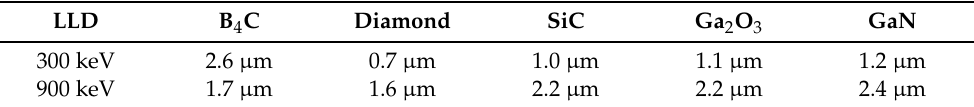
Table 4. Optimal semiconductor thickness with optimal B 4 C converter layer thickness for diamond, SiC, Ga 2 O 3 and GaN semiconductor materials. The optimal converter layer thicknesses are 2.6 µ m for 300 keV LLD and 1.7 µ m for 900 keV LLD, as shown in Table 1.